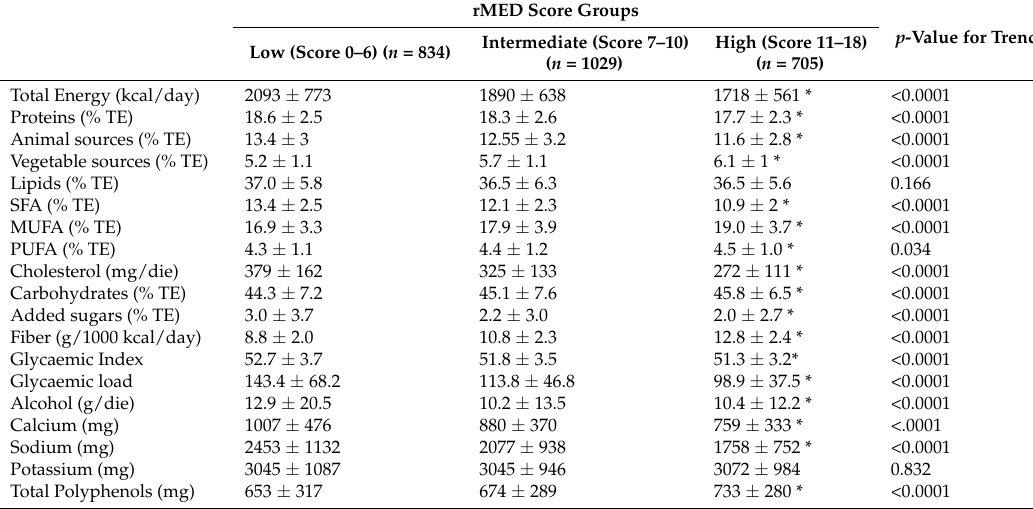
Table 3. Energy and nutrient composition of the diet by rMED score